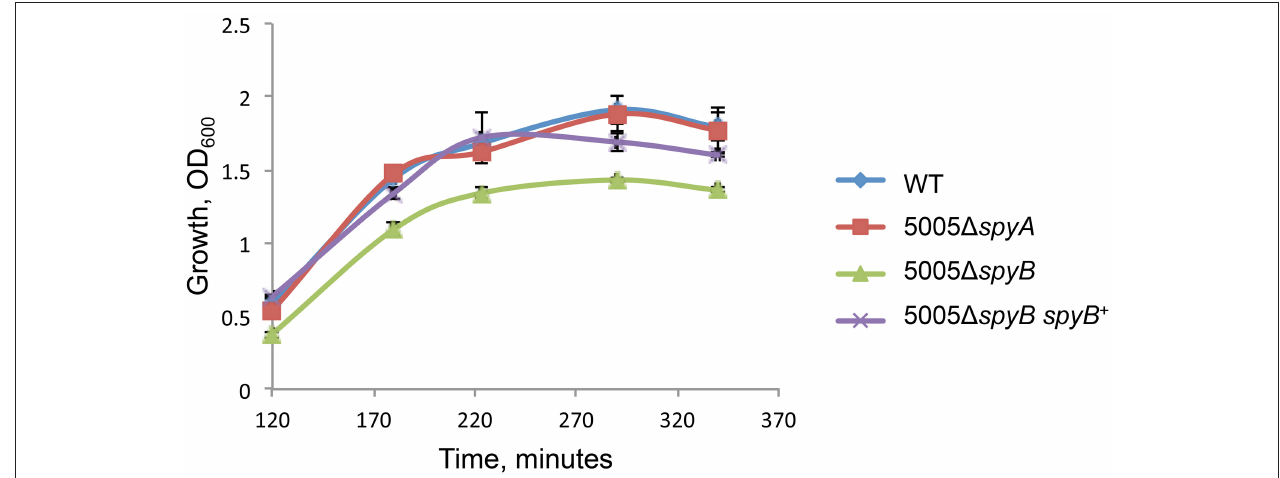
FIGURE 2 | SpyB deficiency causes MGAS5005 cells to aggregate. MGAS5005, 5005 1 spyB , 5005 1 spyB spyB + , and 5005 1 spyA strains at middle exponential phase were examined by microscopy. (A) MGAS5005 strains were Gram stained and imaged by light microscopy. (B) MGAS5005 strains were stained with fluorescently labeled vancomycin to visualize the cell walls and septa, and imaged by fluorescence microscopy. (C) Fixed cultures of MGAS5005 and 5005 1 spyB were visualized by transmission electron microscopy or (D) scanning electron microscopy.